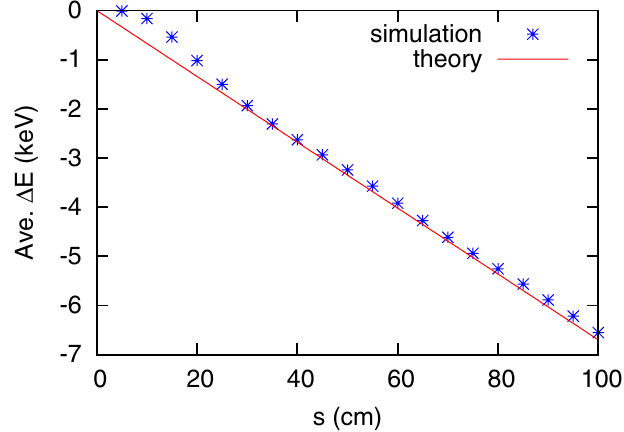
FIG. 7. (Color) Average power loss from the TE(1,0) synchro- nous mode in a square toroidal waveguide as a function of distance s along the bend. The bending radius is 120 cm, and the width and height are 2.5 cm. The bunch length (cid:4) 0 : 115 cm , and the rms beam width is (cid:4) ? (cid:1) 0 : 07 cm . The symbols are the average beam energy deviation (from 100 MeV initial energy) expressed in keV, and the line is a theoretical prediction of 67 eV = cm . The simulation results reaches a steady-state loss rate of 66 eV = cm , which differs from the theoretical prediction by 1.5%.